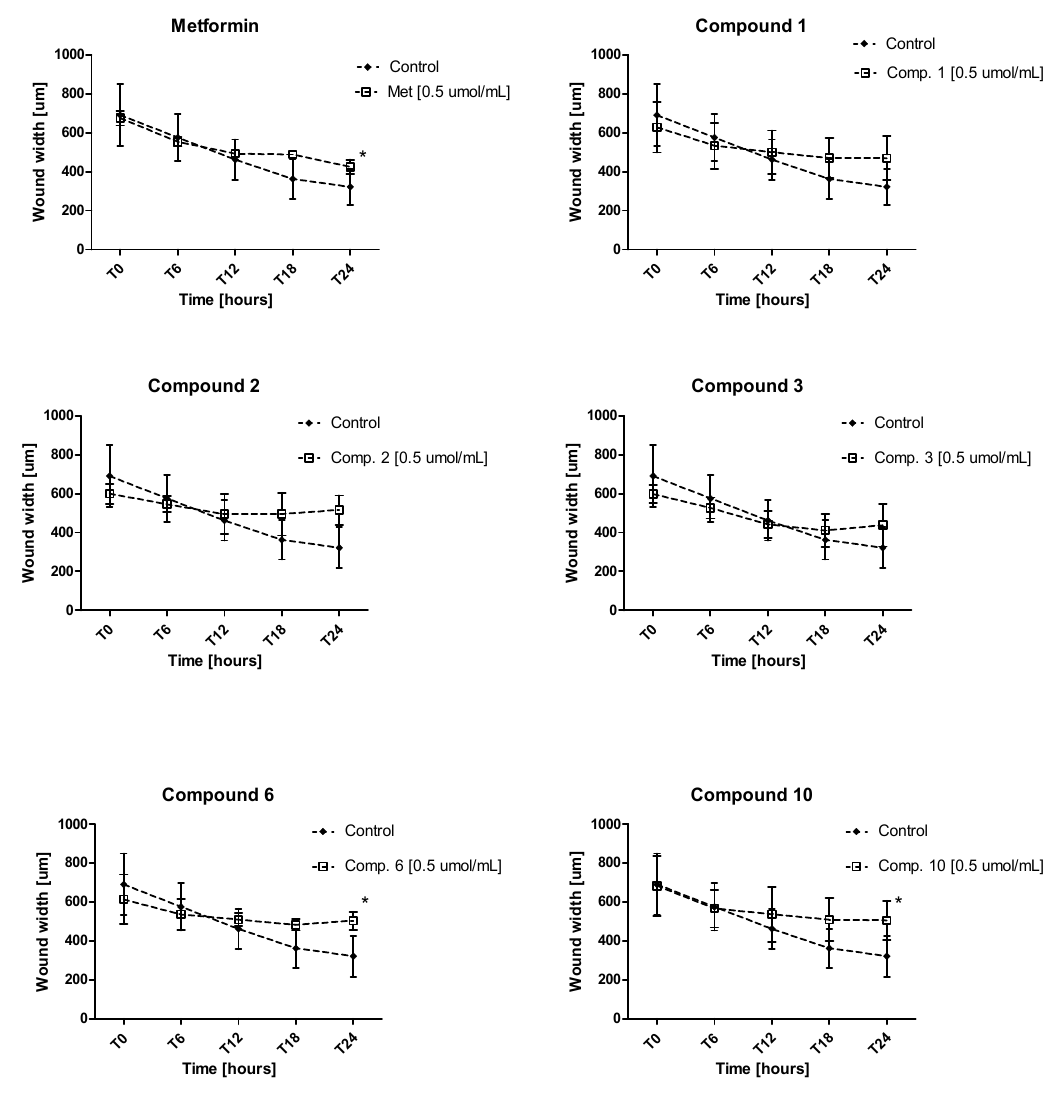
Figure 4. Inhibition of cell migration in the presence of selected compounds (metformin, compounds 1 – 3 , 6 , 10 ). HUVEC cell migration was evaluated using wound healing assay performed in the JuLiStage system. Graphs depict changes of the wound width [µm] during 24 h in the absence (control) and in the presence of examined compounds at 0.5 µmol/mL. The results are presented as mean ± SD ( n = 4–8). * p < 0.05 compared with control.